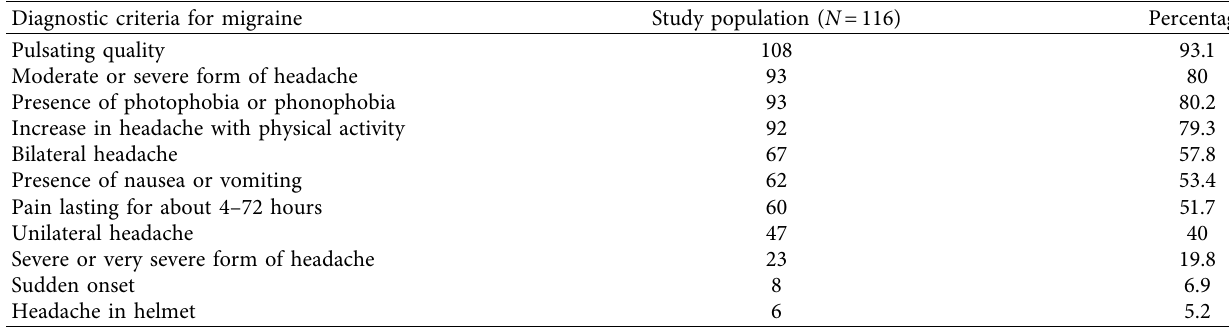
Table 2: Criteria used to establish the diagnosis of migraine ( N �